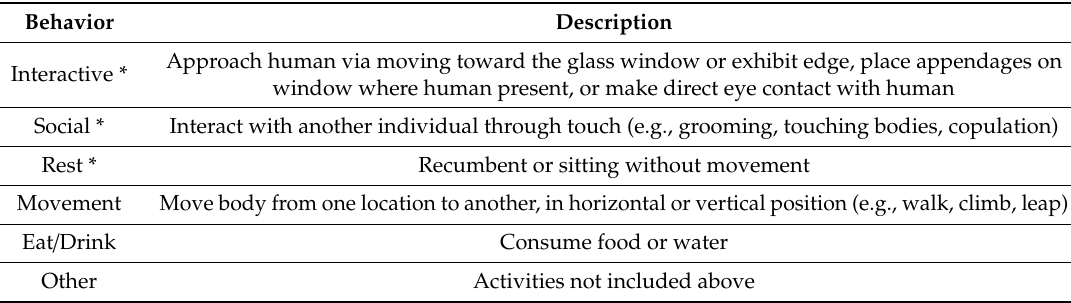
Table A8. Gibbon ethogram, with behaviors of focus indicated with an asterisk